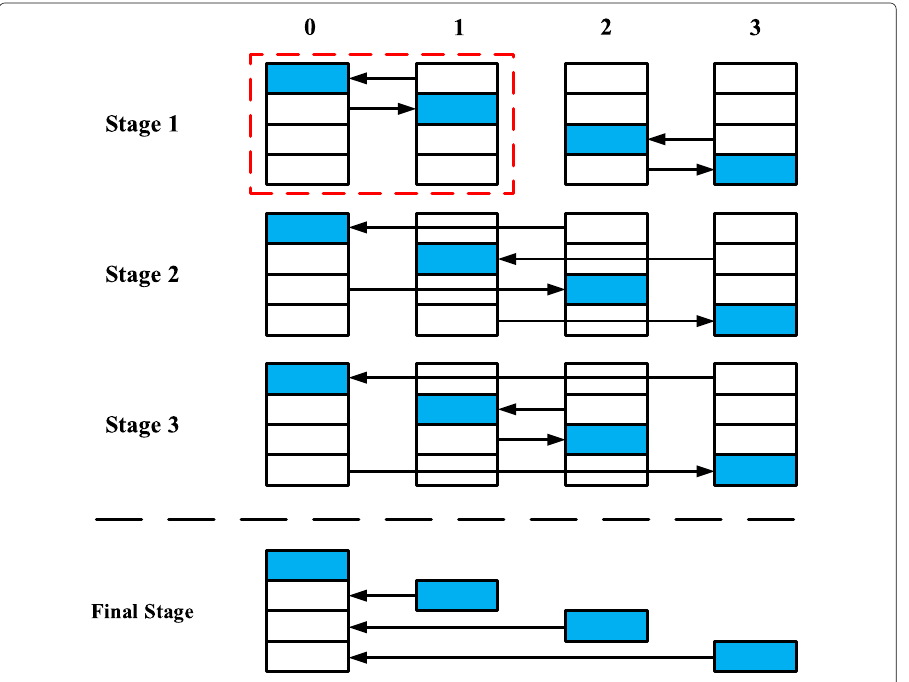
Fig. 1 Direct send. For example, there are four processors involved in image compositing progress. In each processor the data is divided into four parts. The one marked in blue indicates the part that the processor is responsible for. At each stage, processors swap data with each other as framed by red dotted line